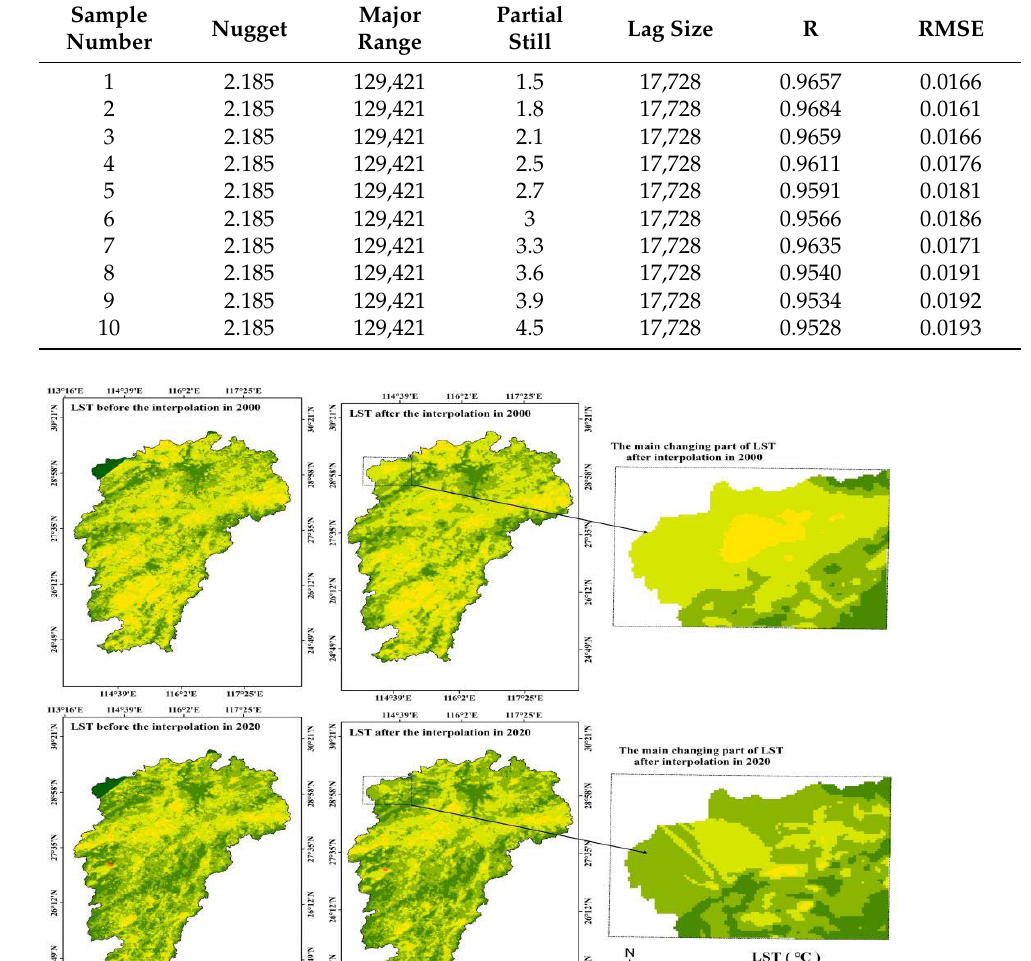
Table 1. Different parameters of kriging interpolation and corresponding random sampling point correlation coefficient and root mean square error.